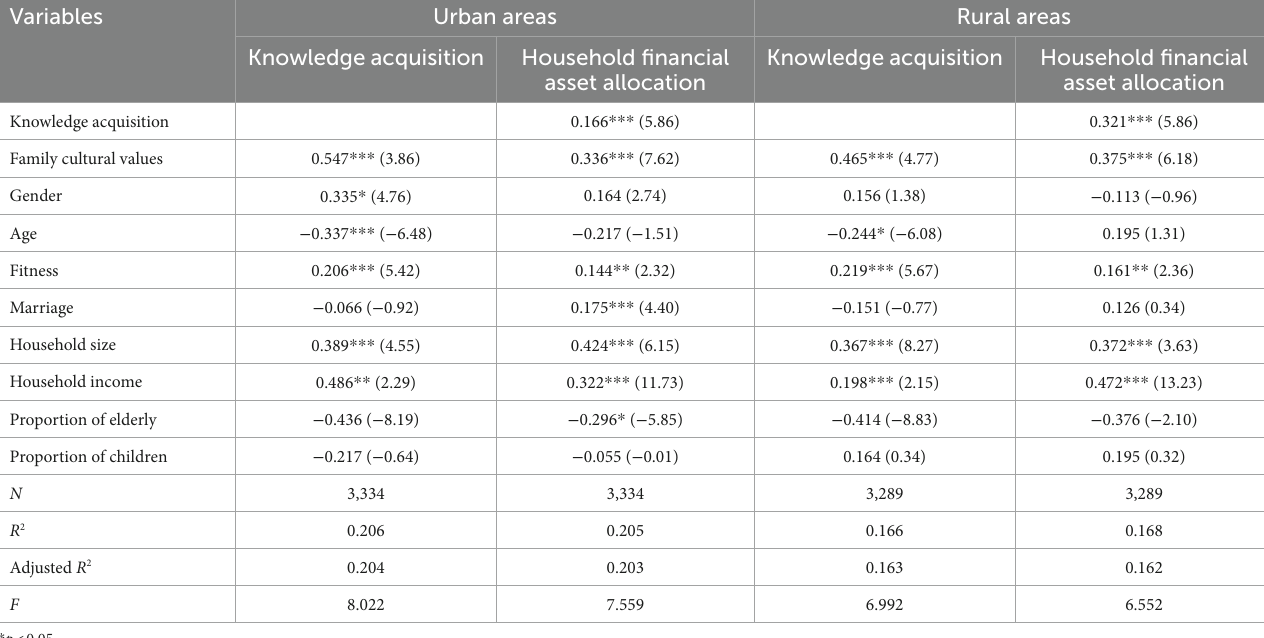
TABLE 3 Mediating effect of knowledge acquisition.